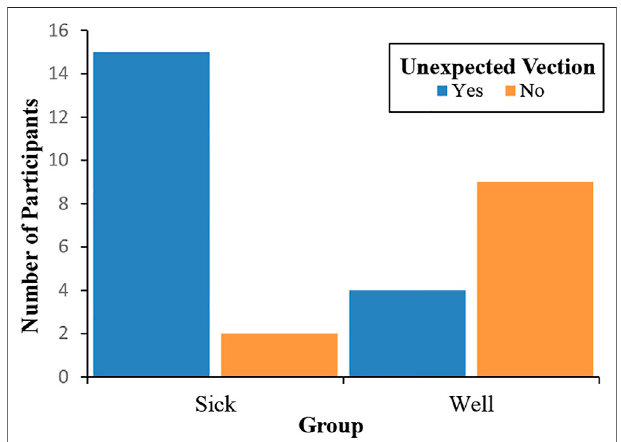
FIGURE 2 | Numbers of “ sick ” and “ well ” participants who did (and did not) experience unexpected vection during HMD